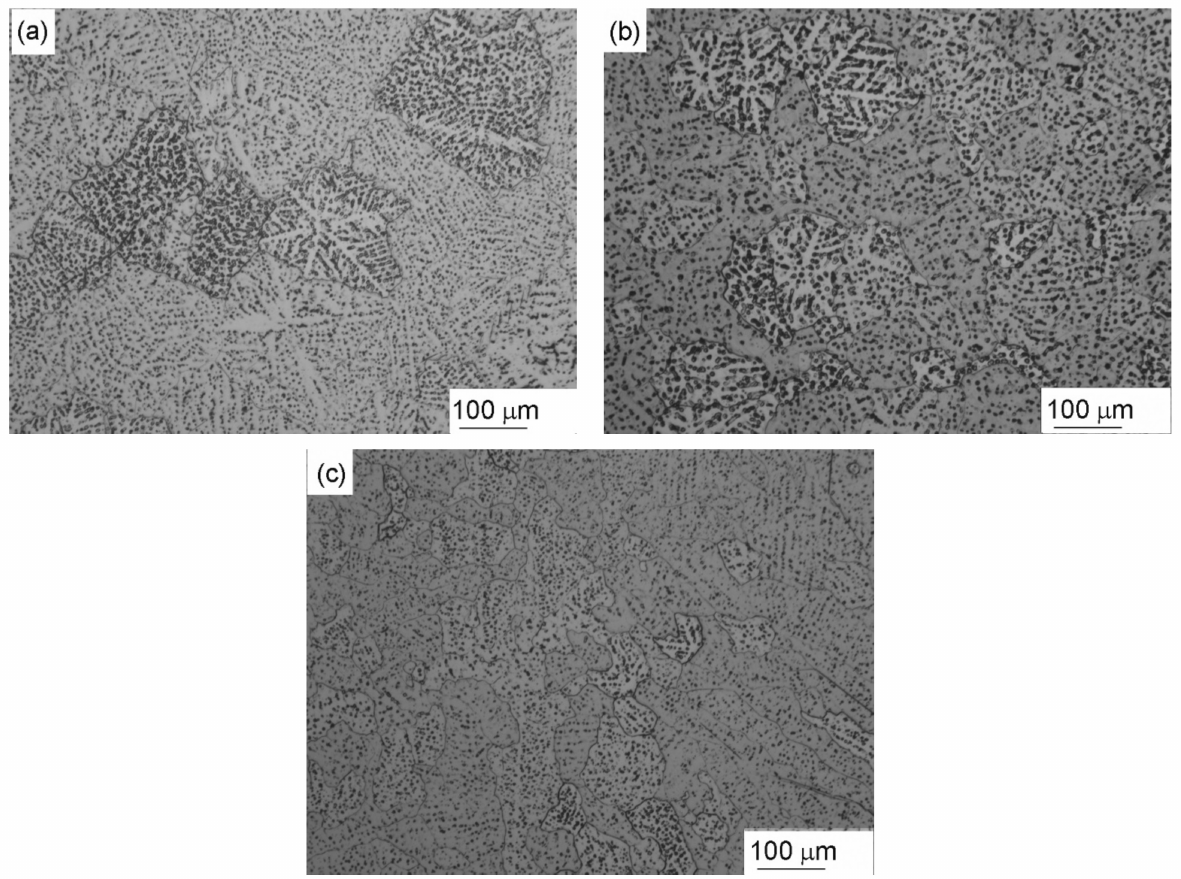
Figure 4. Optical microstructures of equiaxed grains in the fusion zone for welds made at different welding speeds. ( a ) 3 mm/s, ( b ) 4 mm/s, and ( c ) 5